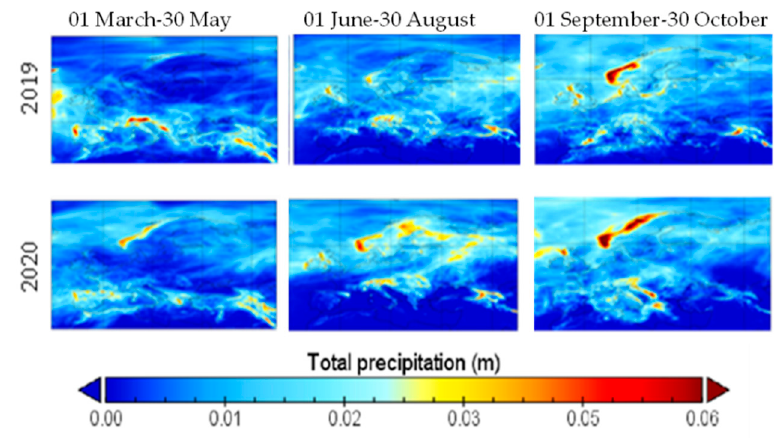
Figure 9. Mean of total precipitation over Europe in three periods, 2019 and 2020.